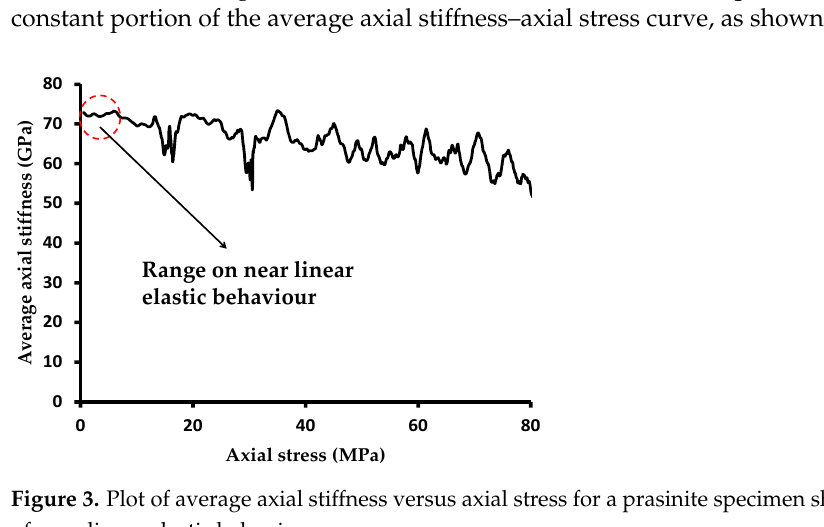
Figure 3. Plot of average axial stiffness versus axial stress for a prasinite specimen showing the range of near-linear elastic behavior.